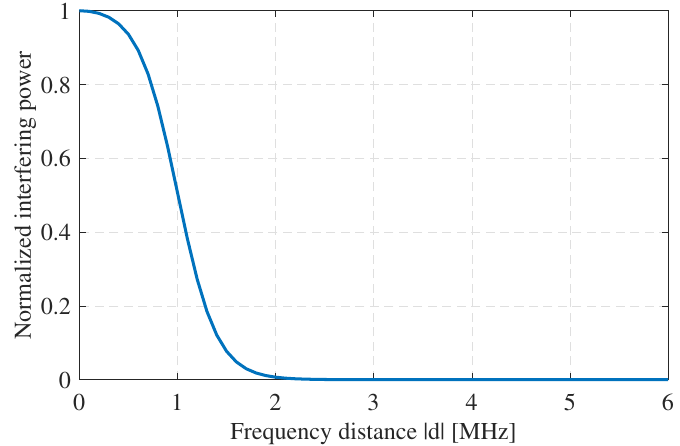
Figure 6. Relation between the interfering power and frequency separation between the victim radar and interfering radar at an IF/baseband filter of bandwidth 1